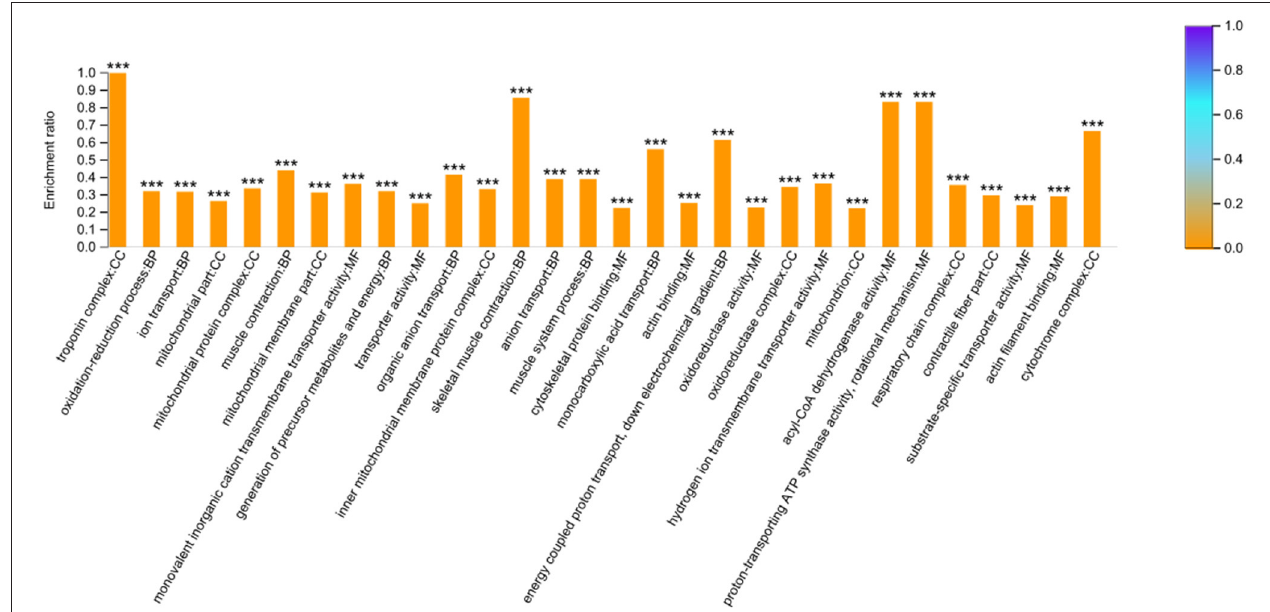
FIGURE 2 | GO enrichment analysis based on the 664 differentially expressed proteins. The top 10 categories in biological process (BP), cellular component (CC) and molecular function (MF) were presented. The *** symbol indicates the P -values <